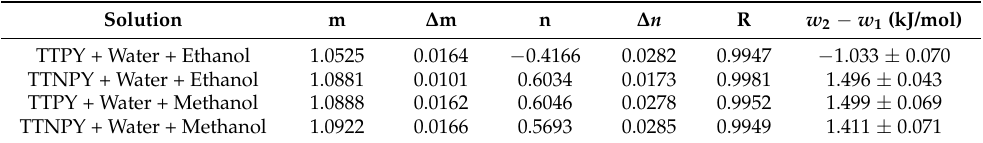
Table 6. Characteristics of the lines ln p 1 tures solutions.